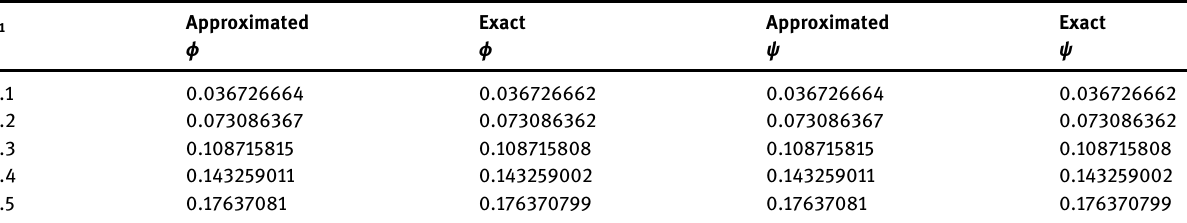
Table 6: Comparison of approximated and exact solutions at t = 1 for N = 11 regarding Example